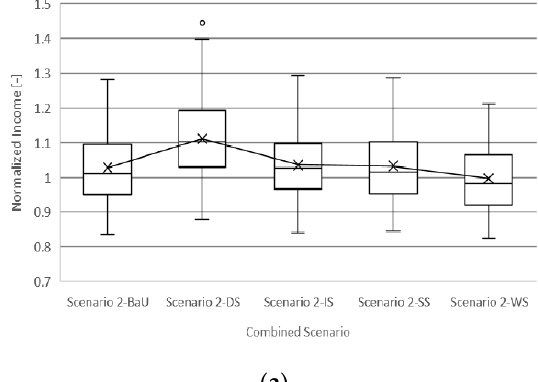
Figure 9. Evolution of the reservoir’s volumes with a 95% confidence interval at 2030 for mixed scenarios. ( a ) Climate scenario 2 with all price scenarios and ( b ) climate scenario 9 with all price scenarios.